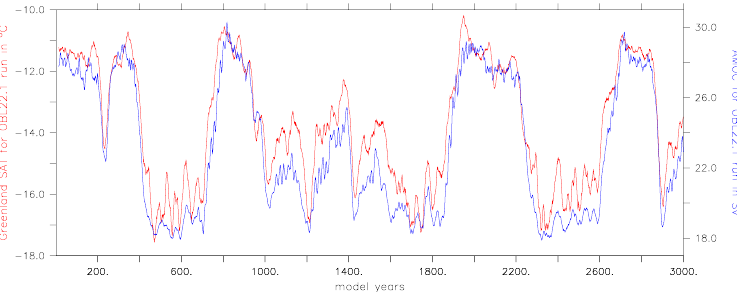
Fig. 9. Red: SAT over Greenland in ◦ C for OBL22.1 run. SAT was averaged over 60 ◦ W to 30 ◦ W and 60 ◦ N to 80 ◦ N. Blue: AMOC for OBL22.1 run in Sv. A running mean of 25years was applied for both